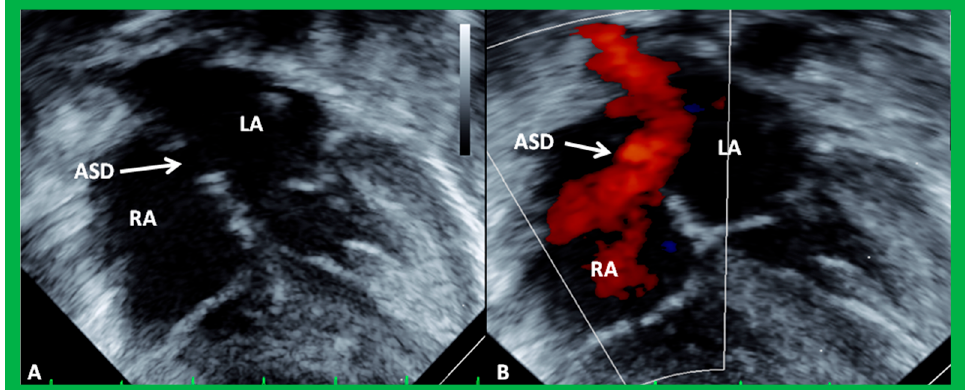
Figure 3. 2D echocardiogram ( A ) and color flow imaging ( B ) in subcostal long-axis view, demon- strating an atrial septal defect (ASD) (arrow in ( A )) with a left-to-right shunt (arrow in ( B )). Left atrium (LA) and right atrium (RA) are marked. Reproduced from Reference [6].